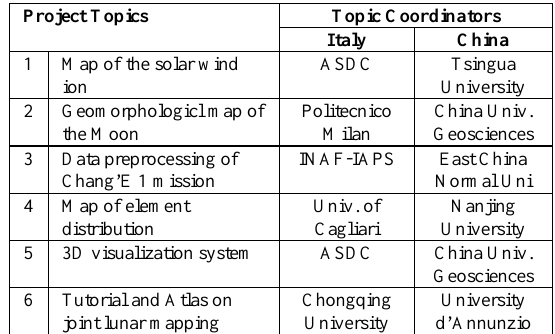
Table 2. – Topics of ‘Moon Mapping Project’ and institutions